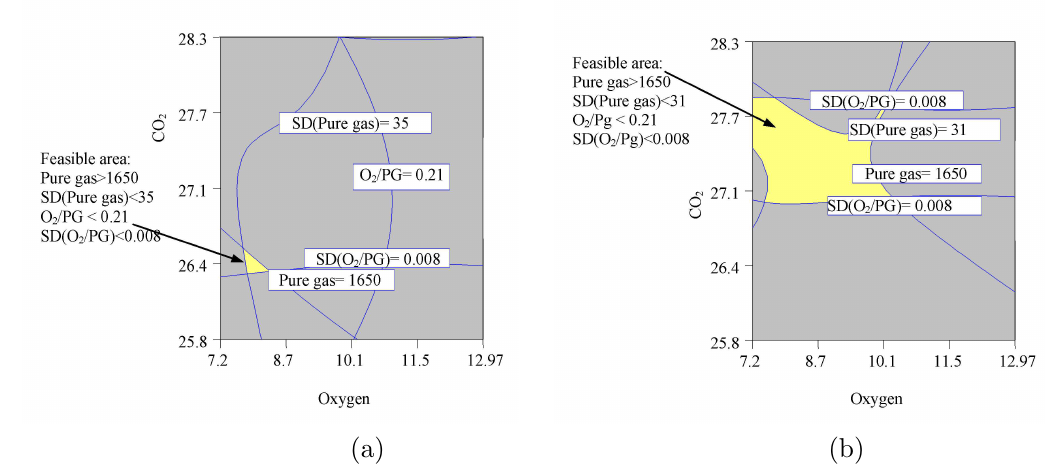
3 n/t DAF, ˆ σ ≤ c 2 m 3 n/t PG ( y ( x, w, z = 10)) ≥ c 1 m PG | z ≤ c 4 m 3 n/m 3 n simultaneously: | z